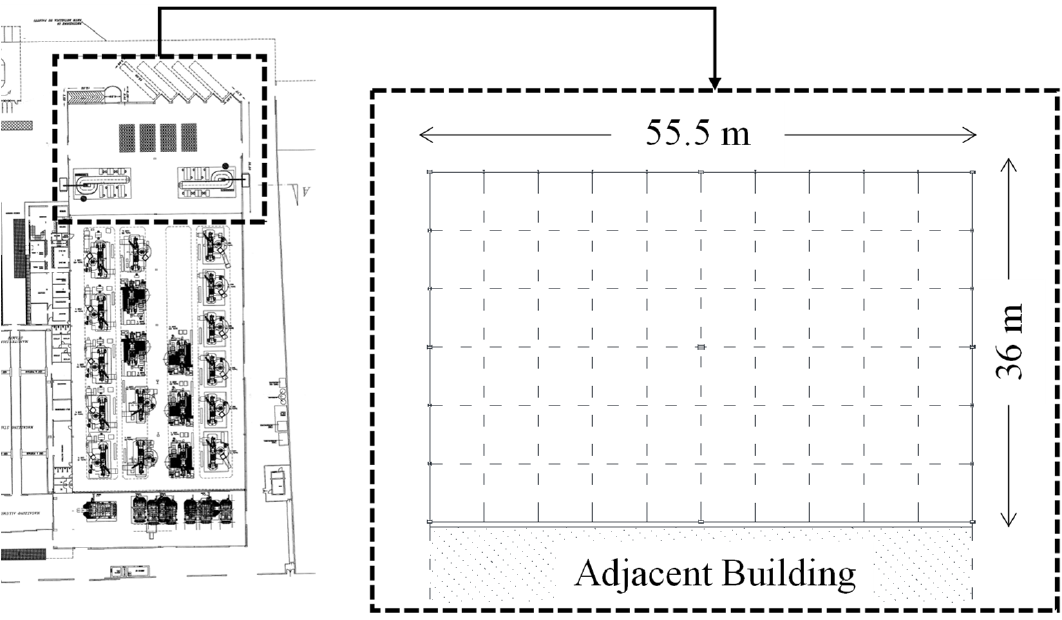
Figure 1. Geometrical features of the selected building according to the original design report.